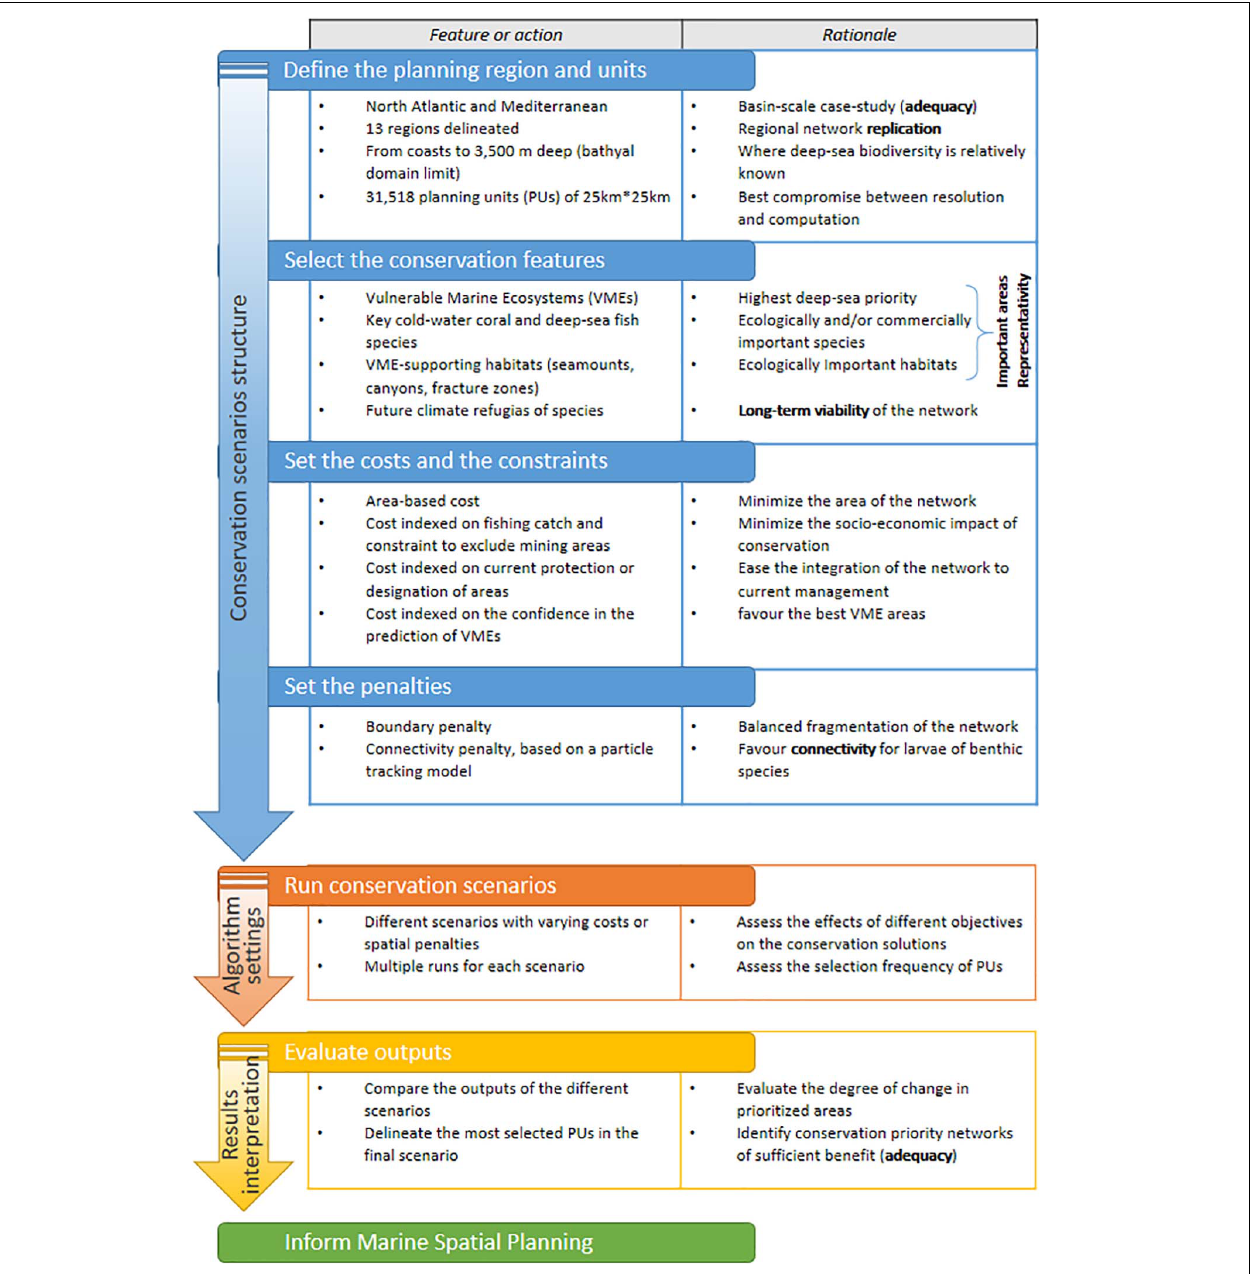
FIGURE 1 | Conceptual flow diagram of the prioritization steps of the framework. The five network criteria for ecological coherence (important areas, representativity, connectivity, replication, and adequacy and viability) as identified by the Convention on Biological Diversity (CBD, 2008), are outlined in